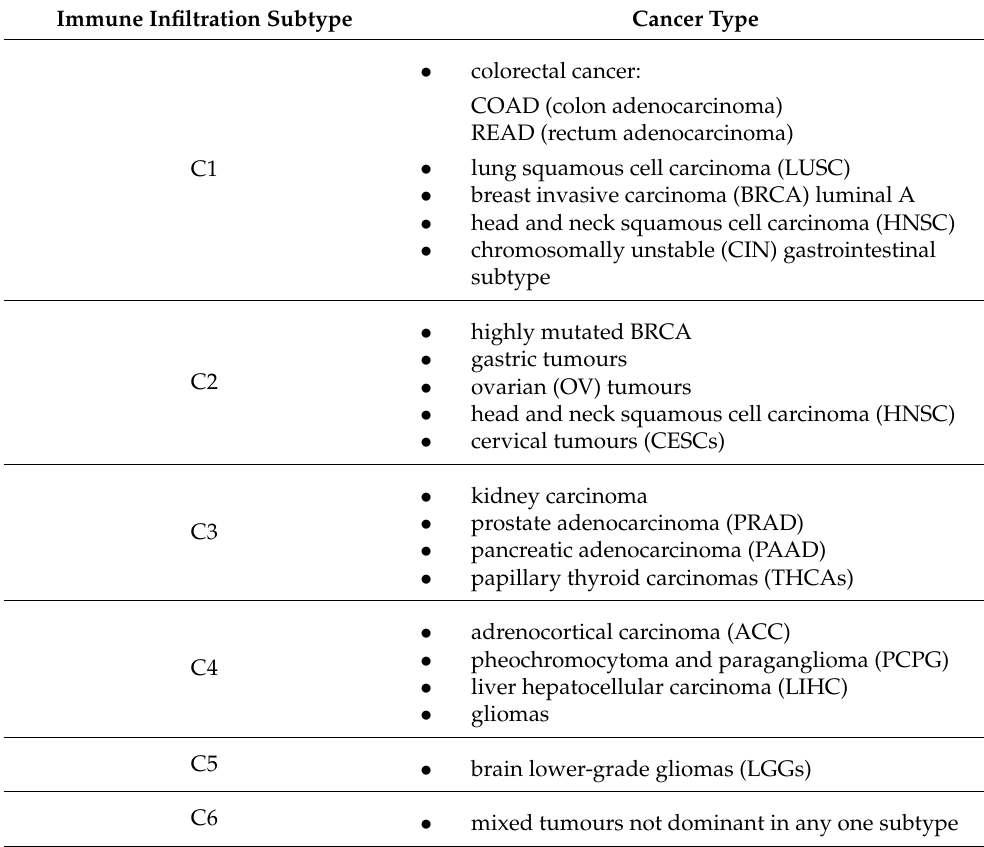
Table 2. Immune infiltration type vs. cancer type